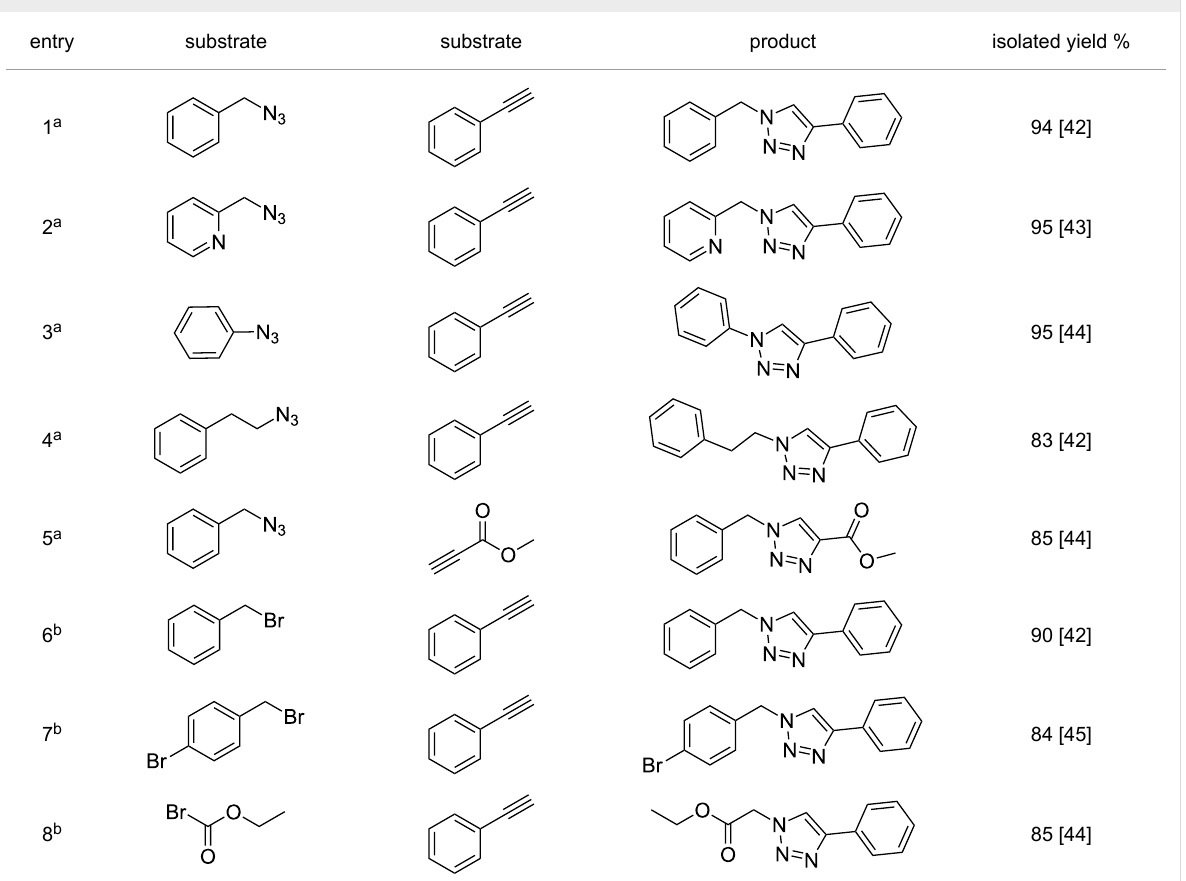
Table 2: CuAAC Reaction using complex 4 as